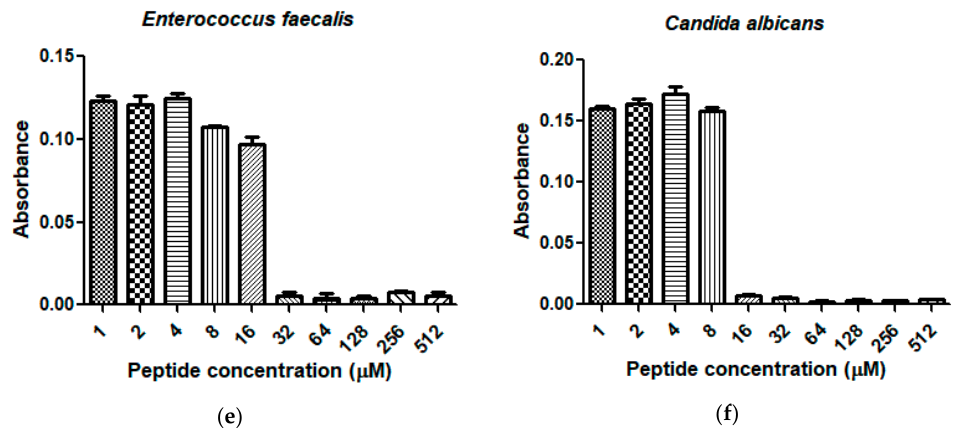
Figure 7. The antimicrobial activities of Dermaseptin-PH against the growth of ( a ) E. coli ; ( b ) P. aeruginosa ; ( c ) S. aureus ; ( d ) MRSA; ( e ) E. faecalis ; and ( f ) C. albicans in a range of concentrations from 1 μ M to 512 μ M. Data represent means ± stand error of the mean (SEM) of 5 replicates.